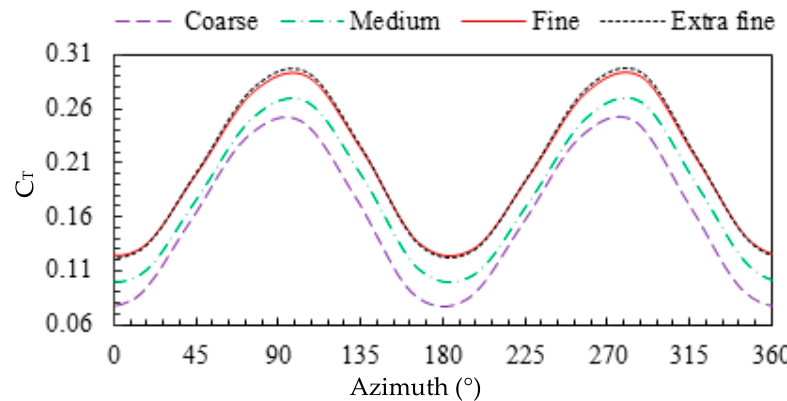
Figure 9. Variation of torque coefficient for different refinement levels of grid.